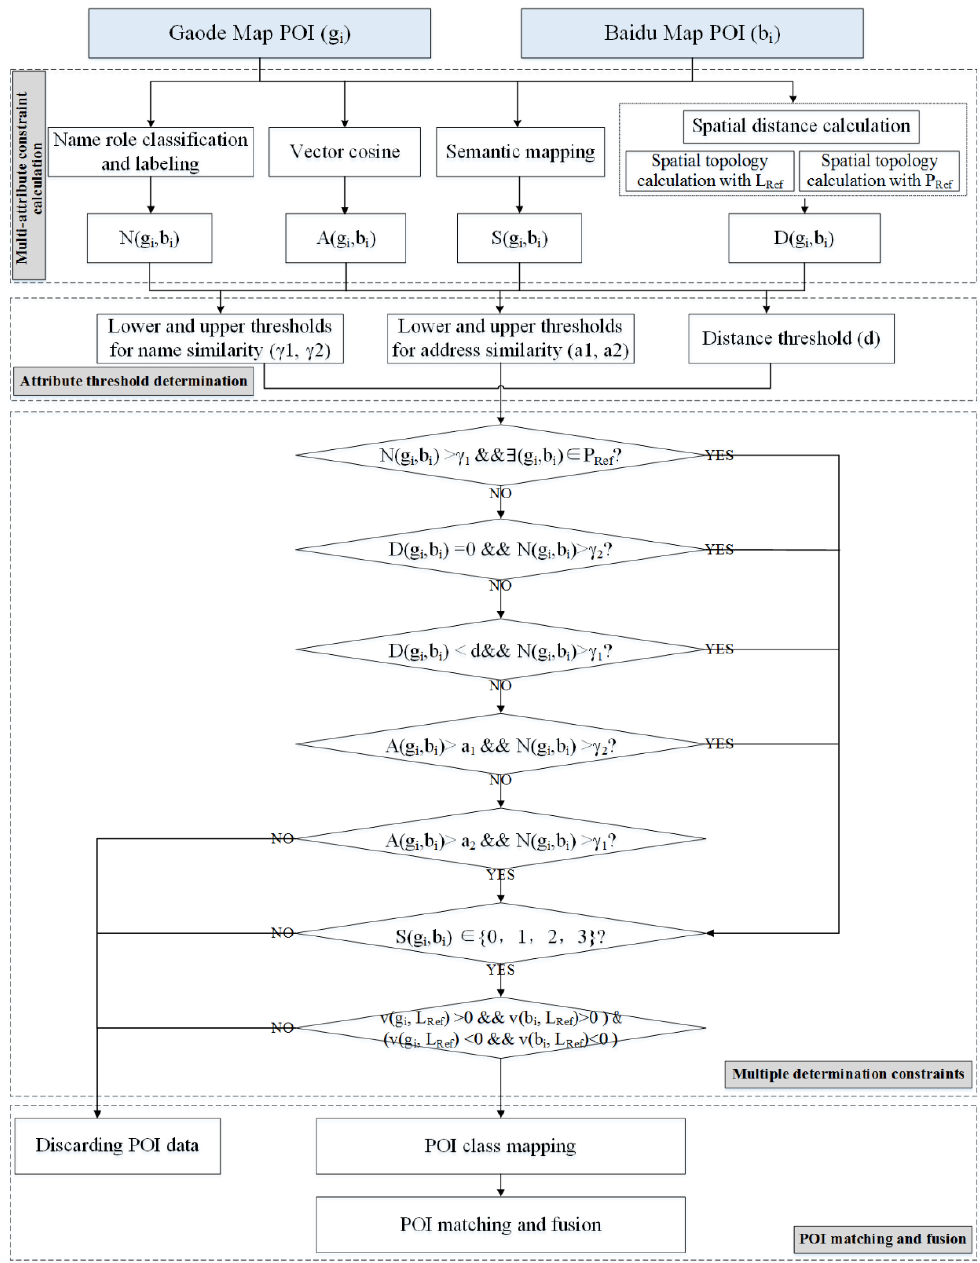
Figure 4. Flow chart of the proposed method.